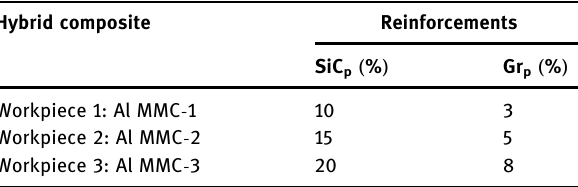
Table 1: Composition merits for three di ff erent Al